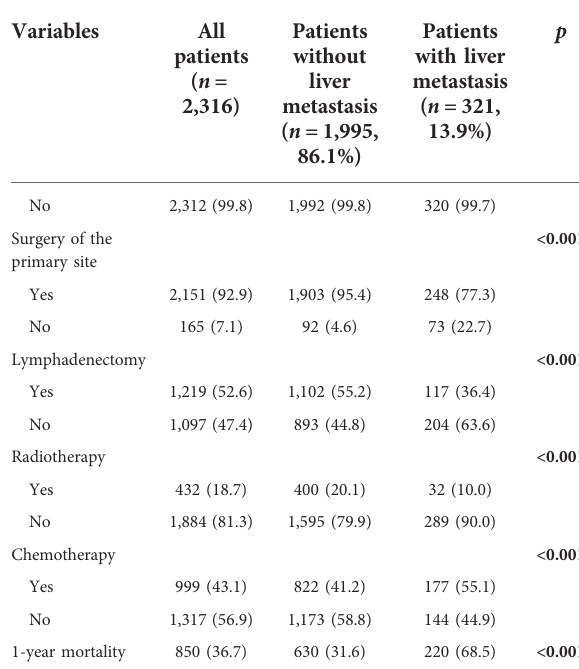
TABLE 1 Baseline characteristics of included gallbladder cancer